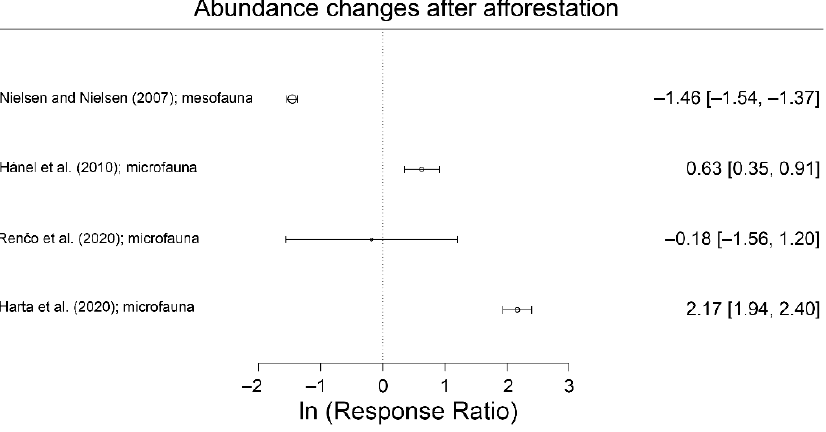
Figure 3. Effect of afforestation of arable lands on soil fauna abundance. The error bars represent 95% confidence intervals (CIs). The circle represents the effect size [5,22,23,32].